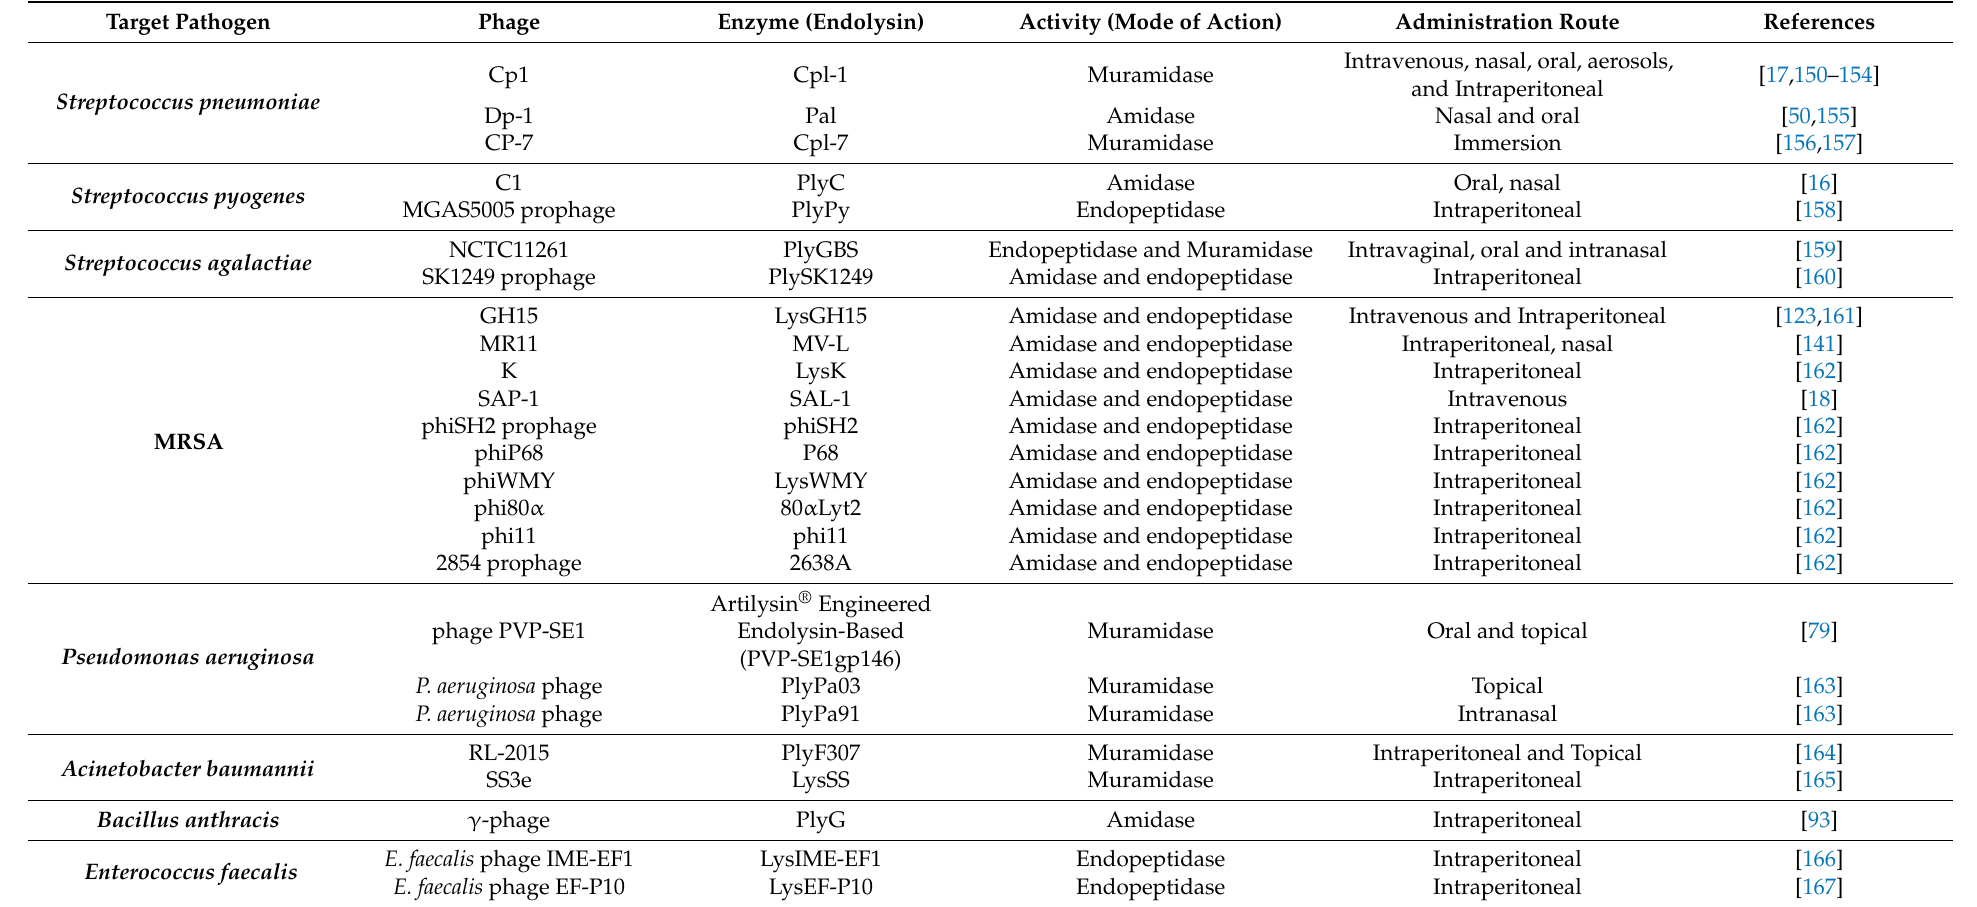
Table 1. Selection of some endolysins and their administration